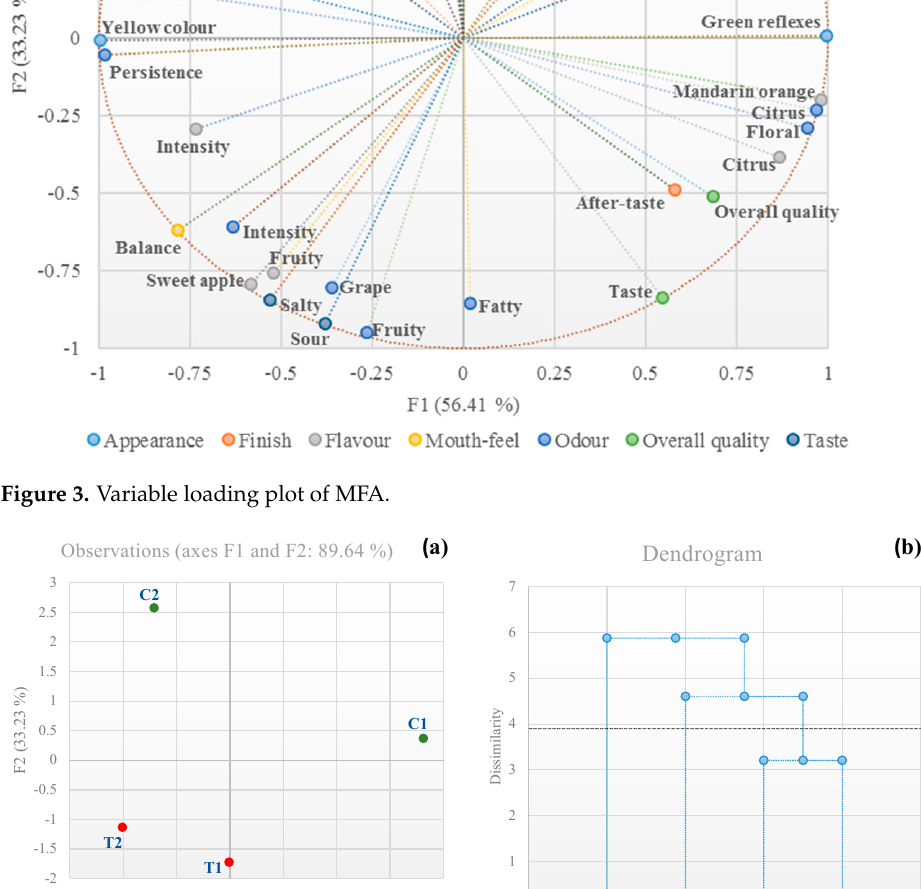
Figure 4. Multiple factor analysis applied to sensory analysis of Catarratto wines: ( a ) sample score; ( b ) agglomerative hierarchical clustering (AHC) dendrogram. Abbreviations: T1, sequential inoculum with M. pulcherrima MP346/ S. cerevisiae SPF52; T2, glutathione-rich inactivated yeasts and sequential inoculum with M. pulcherrima MP346/ S. cerevisiae SPF52; C1, single inoculum with S. cerevisiae SPF52; C2, glutathione-rich inactivated yeasts and single inoculum with S. cerevisiae SPF52.